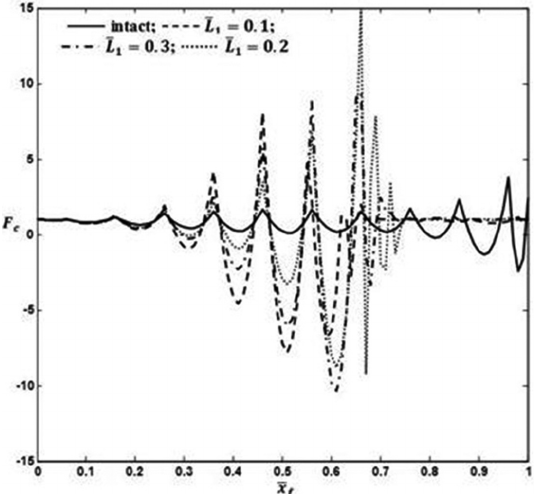
(cid:6) (cid:7) L d = 0 . 4 , interface 1